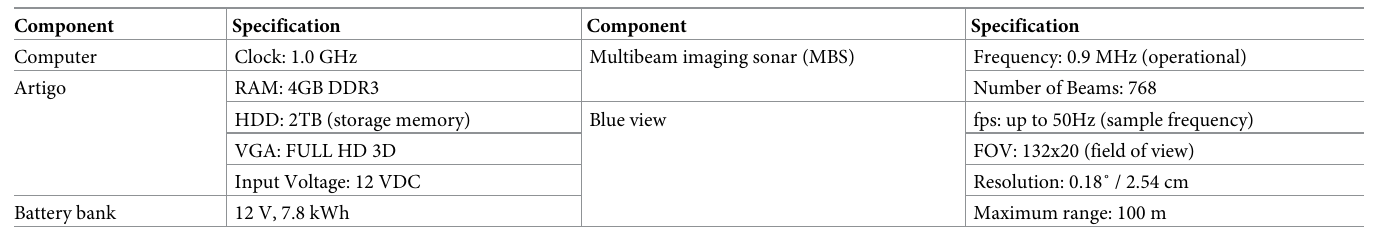
Table 2. Technical specifications of sensors and components used in this study.